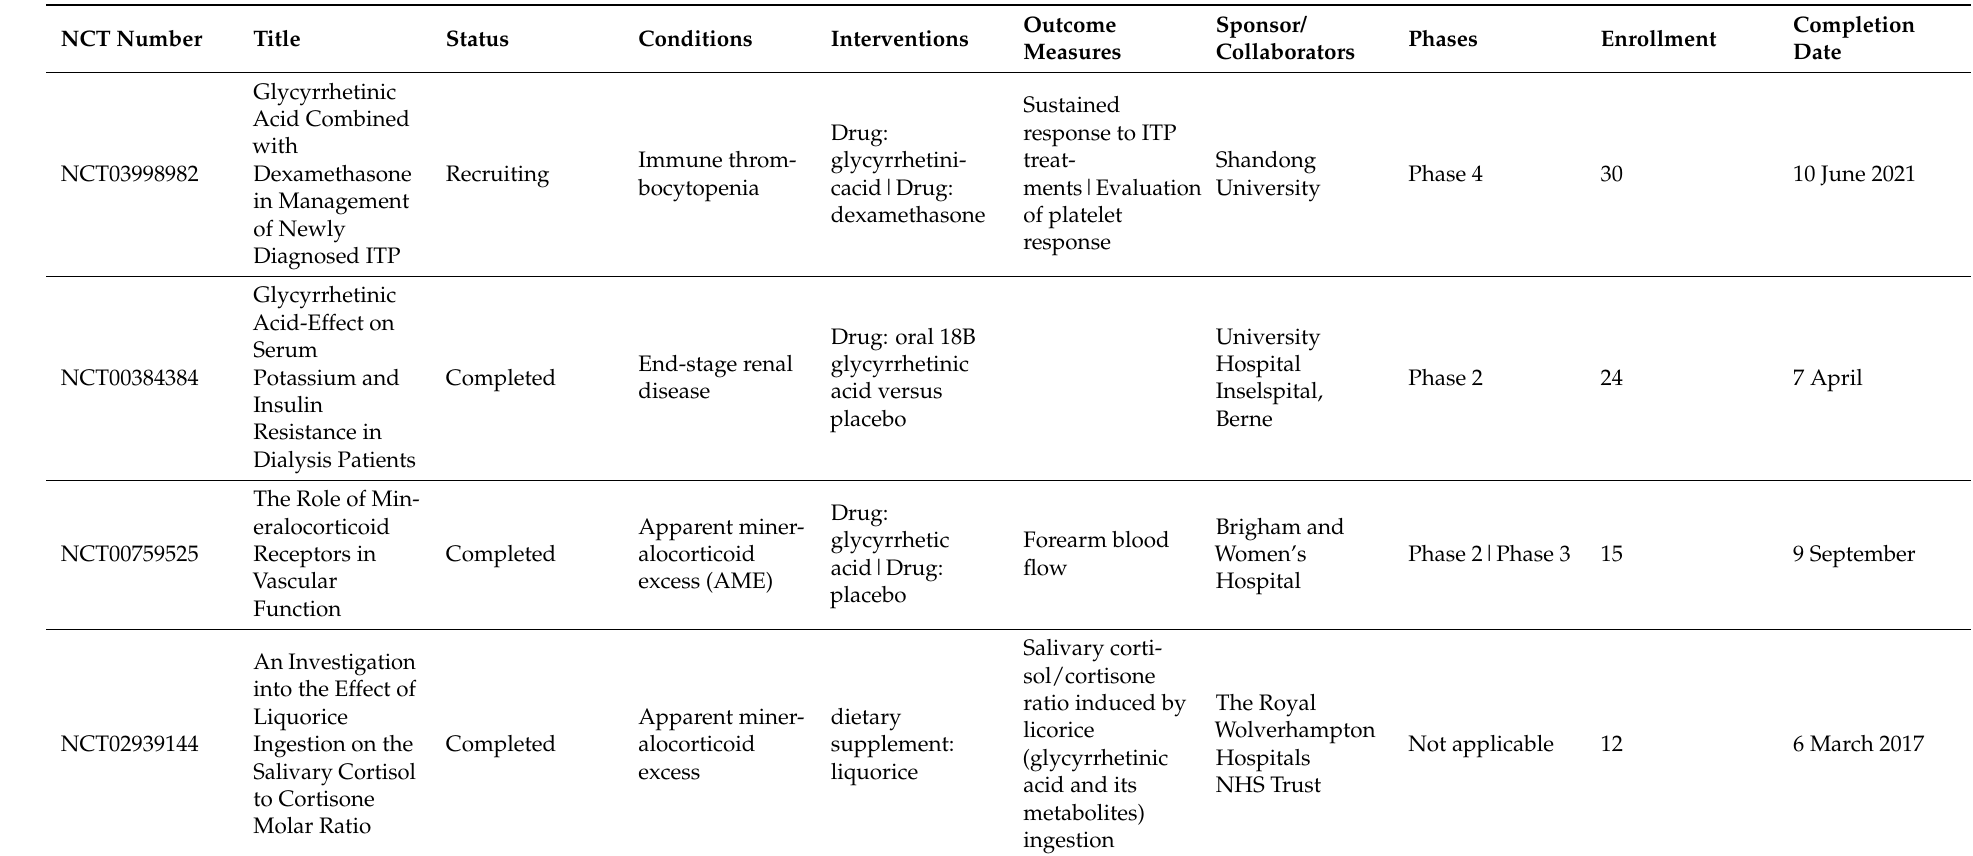
Table 5. Current status of clinical trials on glycyrrhetinic